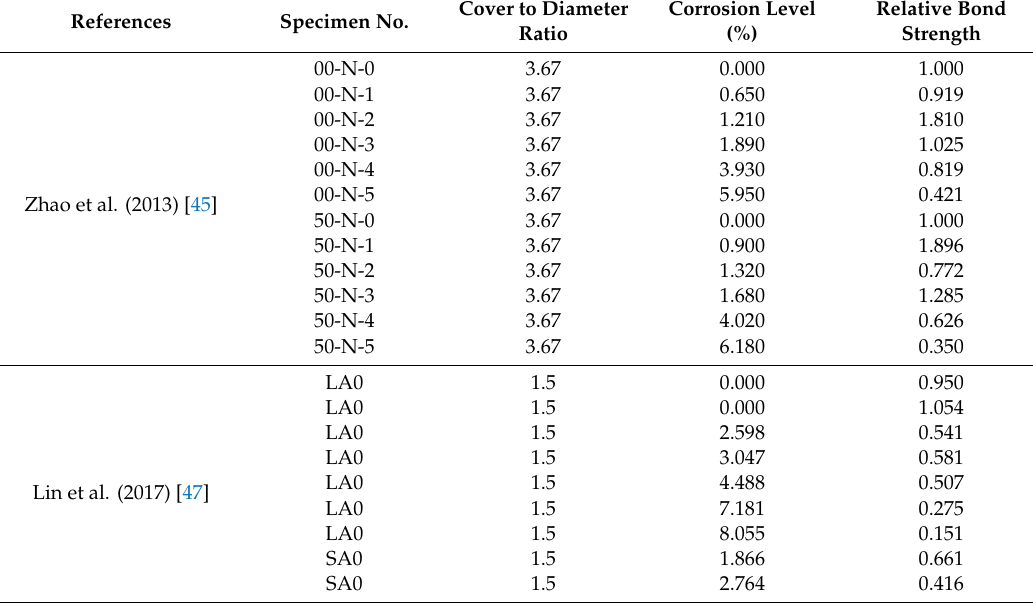
Table A1. Dataset for cases without stirrups and variable with only cover to diameter ratio and corrosion level ( n =